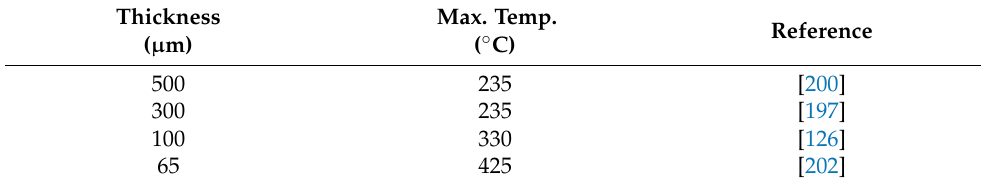
Table 6. Some literature values of maximum operational temperature versus diamond